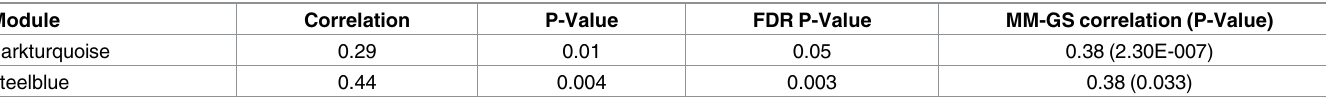
Table 2. Correlation between two network modules and